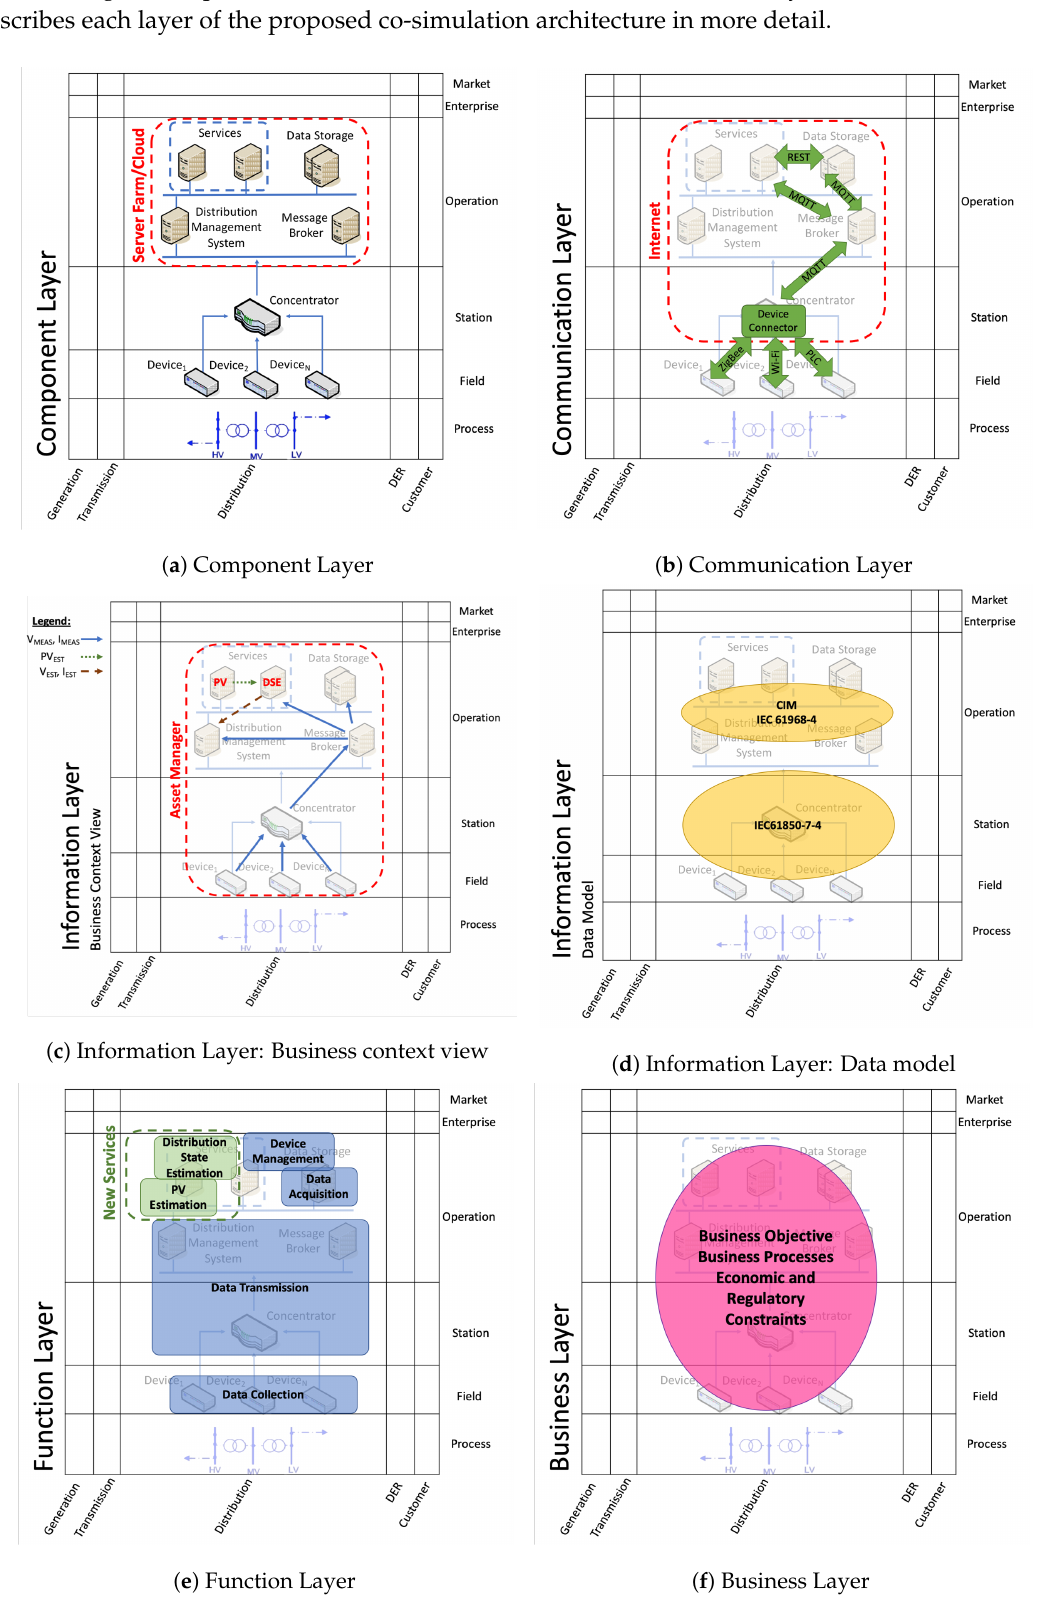
Figure 2. Scheme of the proposed SGAM-based co-simulation